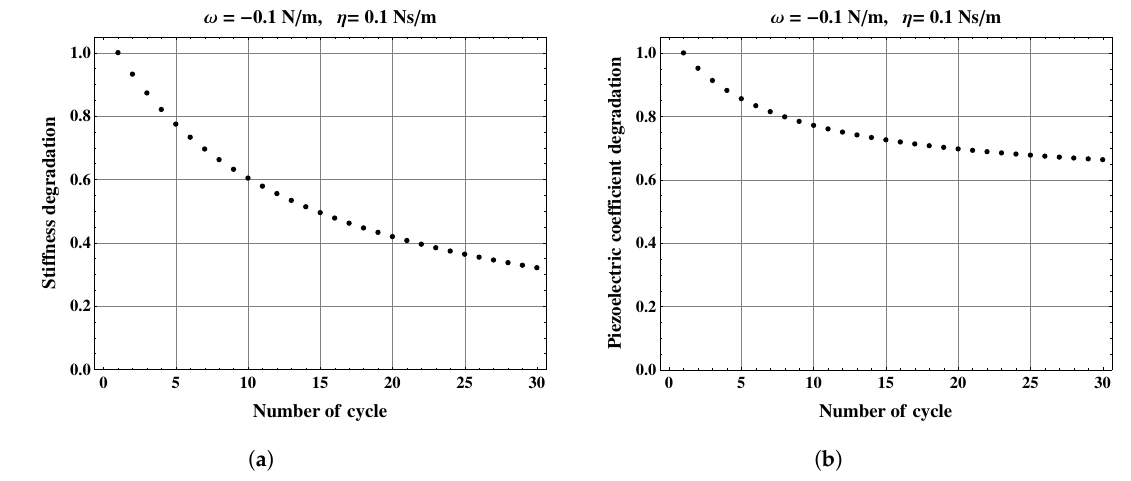
Figure 8. Stiffness degradation ( a ) and inverse piezoelectric coefficient degradation ( b ) versus number of cycle for 30 loading cycles of the layered composite in Figure 2 for material parameters ω = − 0.1 N/m and η = 0.1